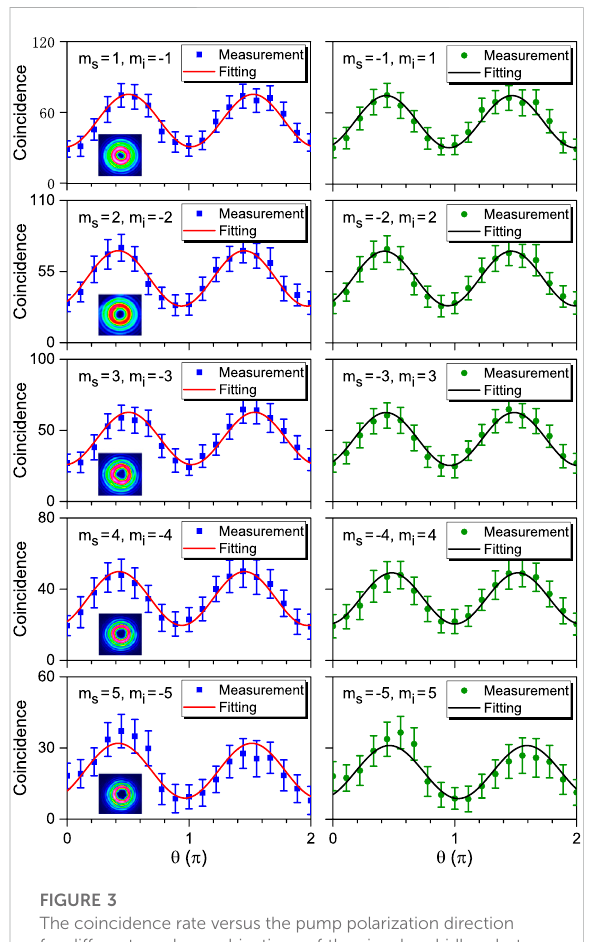
FIGURE 3 The coincidence rate versus the pump polarization direction for different mode combinations of the signal and idler photons from the SPDC. θ is the angle between the pump polarization and the y axis. The coincidence time is 1 s . The insets are the intensity distributions for corresponded OAM.